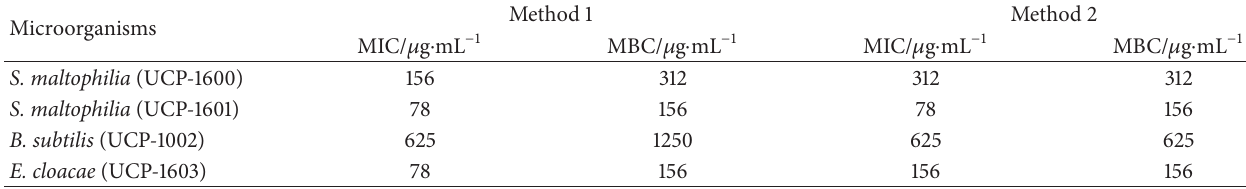
Table 2: Minimum Inhibitory Concentration (MIC) and Minimum Bactericidal Concentration (MBC) of chitosan by Zamani et al. [17] and Arantes [18] on Gram-positive and Gram-negative